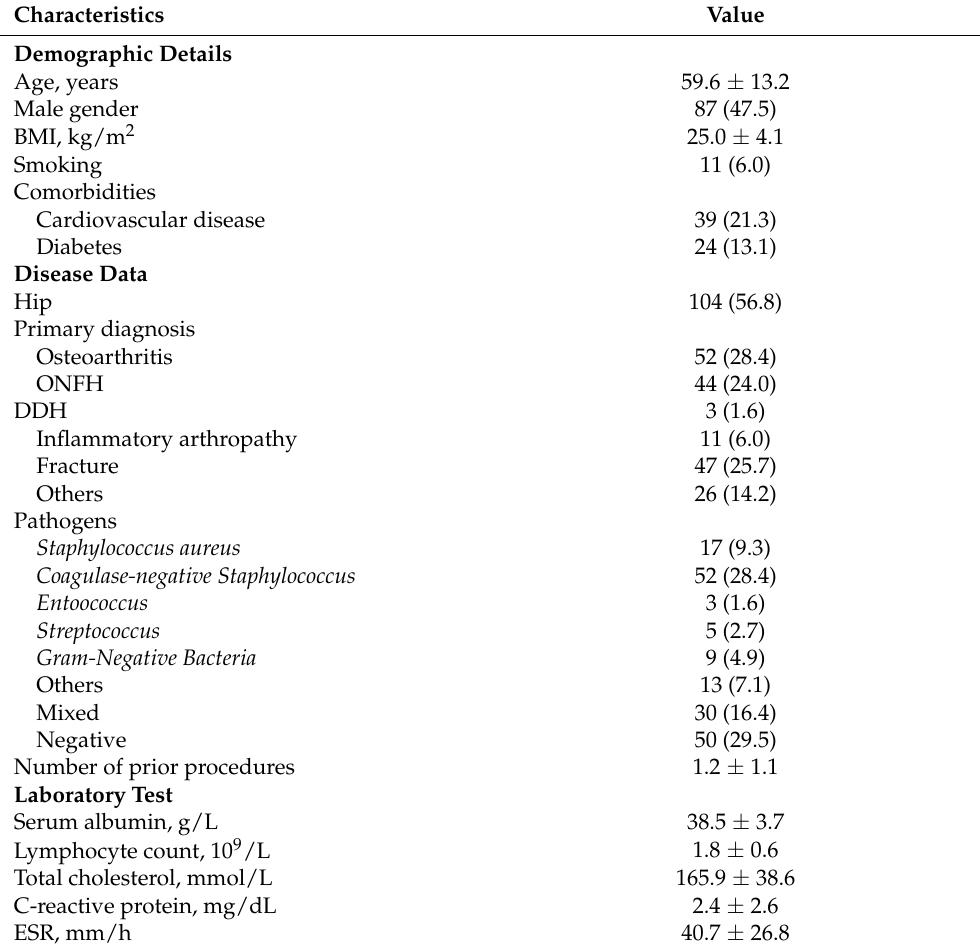
Table 1. Baseline characteristics of the study population at 1st stage exchange. Values are presented as mean ± SD or number of subjects